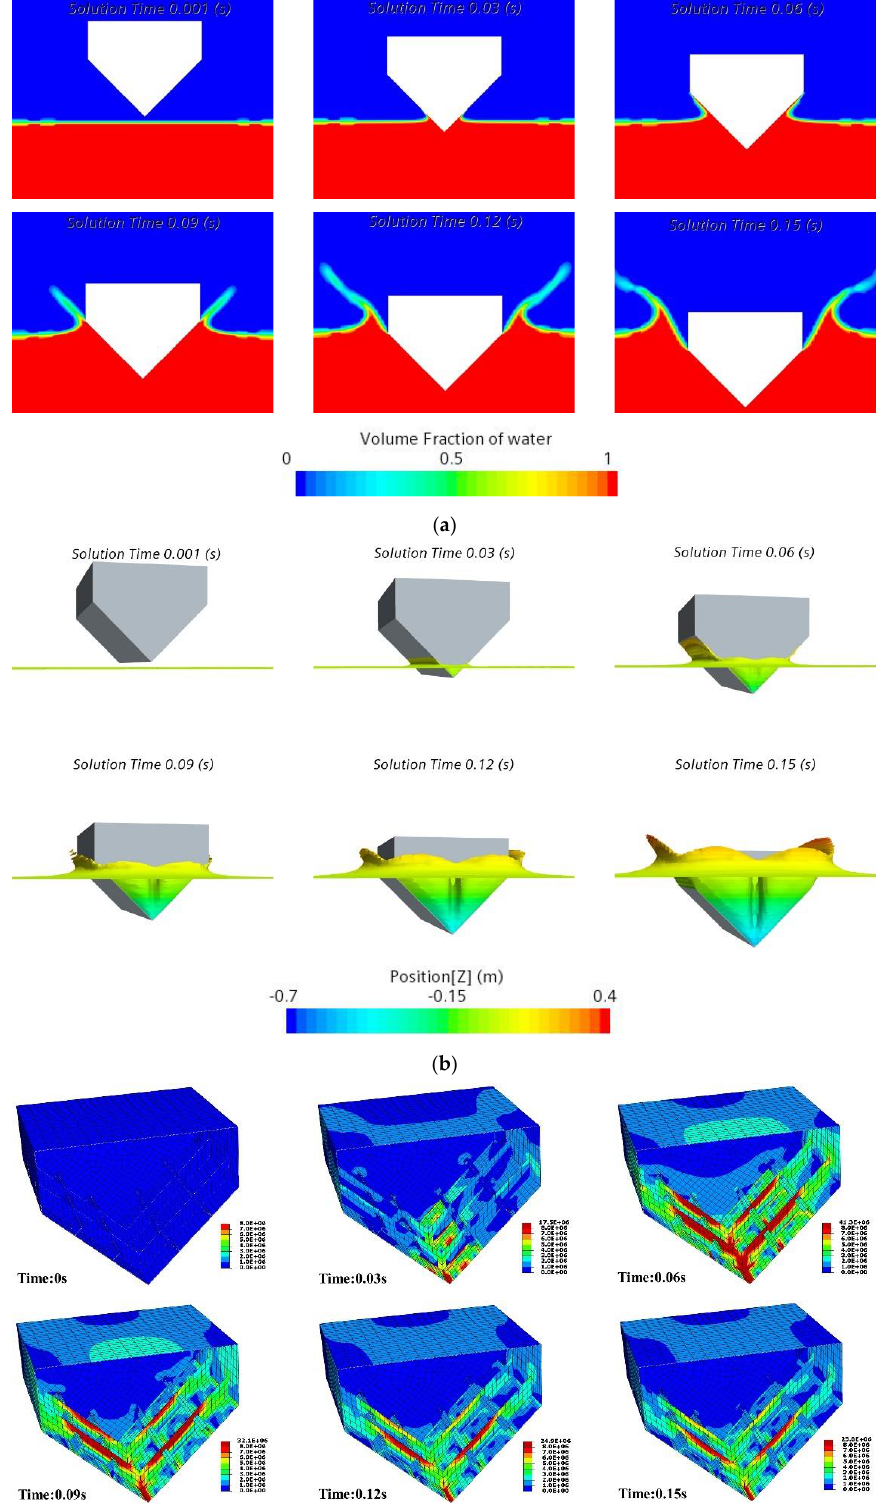
Figure 16. Visualization of FSI results during water entry procedure (Case 4): ( a ) volume fraction of fluid domain; ( b ) free surface around the wedge; ( c ) structural stress distribution on the